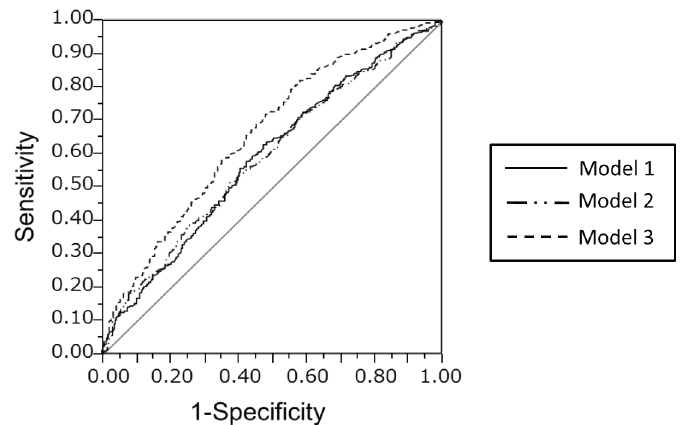
Fig 3. Receiver operating characteristic (ROC) curves for the multiple logistic regression models for low back pain. The area under the curve (AUC) for the ROC curves for models 1, 2, and 3 were 0.59, 0.60, and 0.66, respectively. The AUC for model 3 was significantly greater than the AUCs for models 1 and